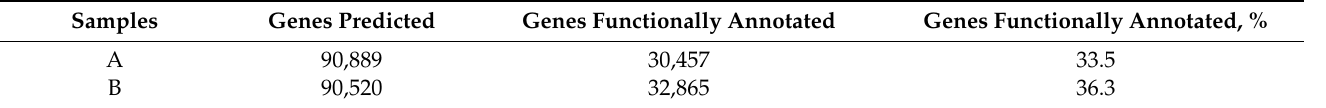
Table 5. Functional annotation of the collected metagenomes.